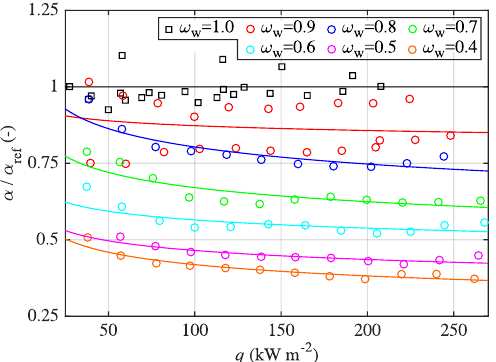
Figure 8. Relative fractions of HTCs of water–glycerin mixtures α related to the HTCs of pure water α ref as a function of heat flux q